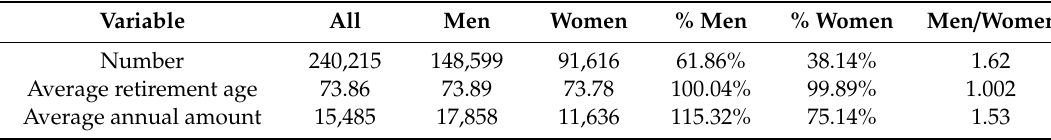
Table 3. Average data on retirement pensions in 2018.